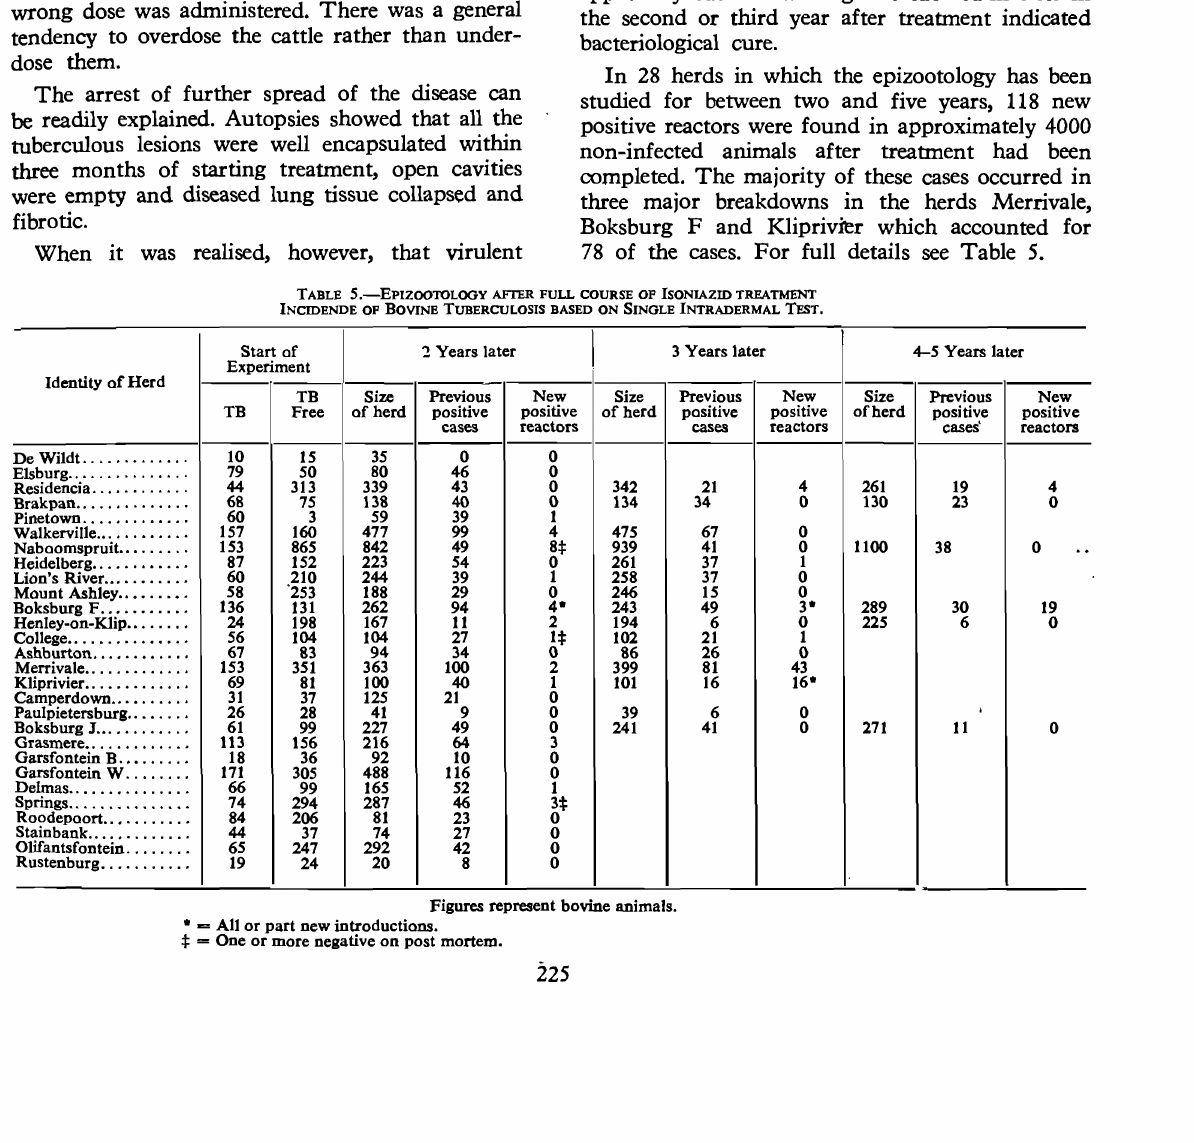
TABLE 5.-EpIZooTOLOGY AFTER FULL COURSE OF ISONIAZID TREATMENT INCIDENDE OF BOVINE TUBERCULOSIS BASED ON SINGLE INTRADERMAL TEsT. Start af 2 Years later Identity of